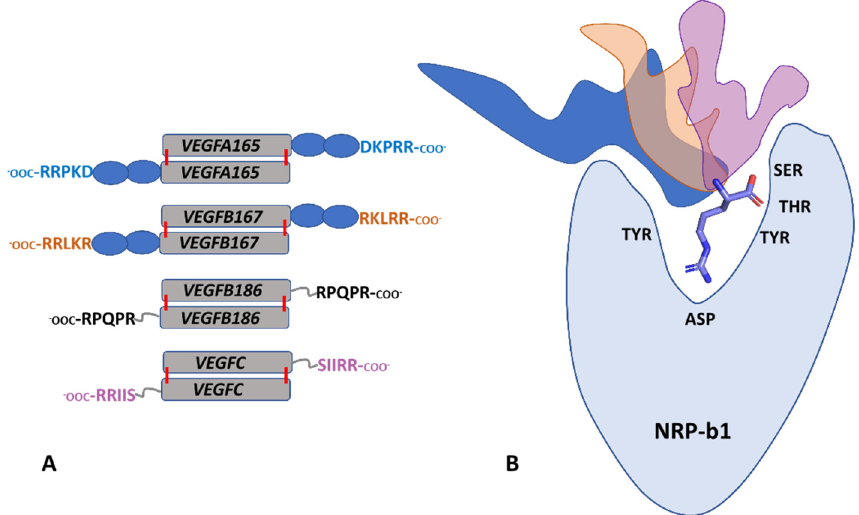
Figure 7. Different VEGF proteins use an overlapping binding site on the b1 domain of neuropilins. ( A ) Domain organization of VEGFA165, VEGFB167, VEGFB186 and VEGFC showing the C-terminal peptide sequences used in this study. The core cysteine-knot domains are colored grey, and the heparin-binding domains are shown in blue. Intermolecular disulfide bonds linking the cysteine-knot domains are illustrated by red lines. Both cysteine-knot domains and heparin-binding domains also contain intramolecular disulfide bonds, but for clarity, these have not been included in the diagram. ( B ) A schematic diagram illustrating how different peptides could be anchored into the NRP-b1 binding site by the C-terminal arginine (represented as sticks) but oriented differently above the molecular surface of the NRP1 or NRP2 b1 domains. NRP-b1 domain is represented in light blue, while the molecular surfaces of the various peptides are shown as dark blue, orange and pink for A165, B167 and C, respectively. Within the simplified representation of the NRP-b1 domain, starting from the left, the amino acid names indicate the relative positioning of TYR297/299, Asp320/323, Tyr353/356, Thr349/352 and Ser346/349 in the NRP1/NRP2 binding sites. Supplementary Materials: The following supporting information can be downloaded at: www.mdpi.com/xxx/s1, Figure S1: Thermal shift assays; Figure S2: SPR data; Figure S3: Radar plots; Figure S4: Interactions between NRP2-b1 Arg303 and the peptide C.